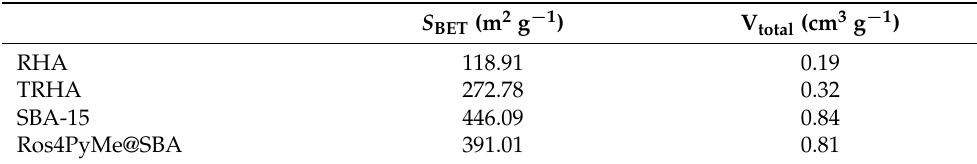
Figure 2. N 2 adsorptiondesorption isotherms of RHA, TRHA, SBA-15, and Ros4PyMe@SBA (adsorption—full lines and desorption—dashed lines). Table 3. Textural parameters of RHA, TRHA, SBA-15, and Ros4PyMe@SBA.